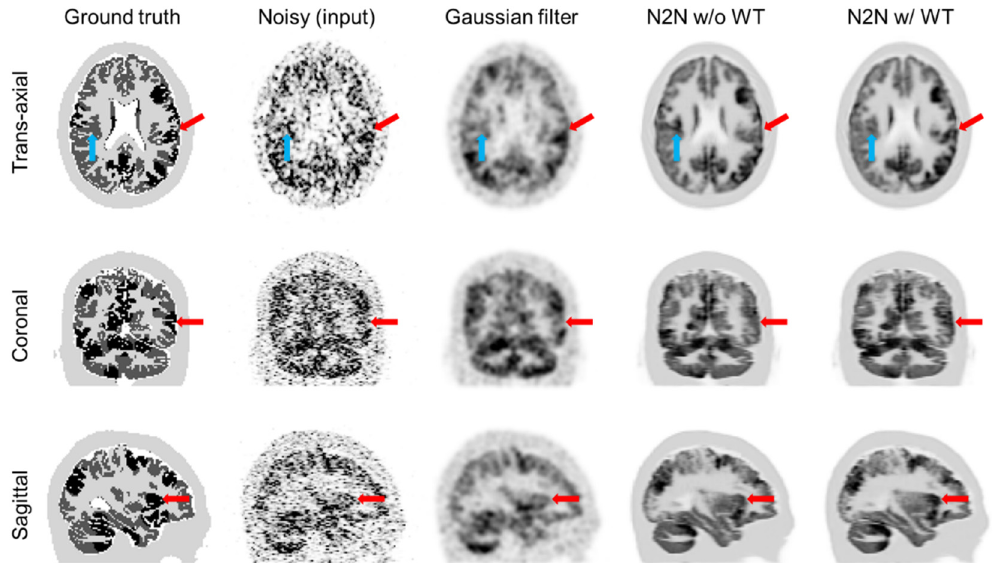
Figure 2. Ground truth, noisy input, Gaussian-filtered, and denoised images using the Noise2Noise (N2N) without and with the incorporation of the trainable wavelet transform (WT) for simulation data.